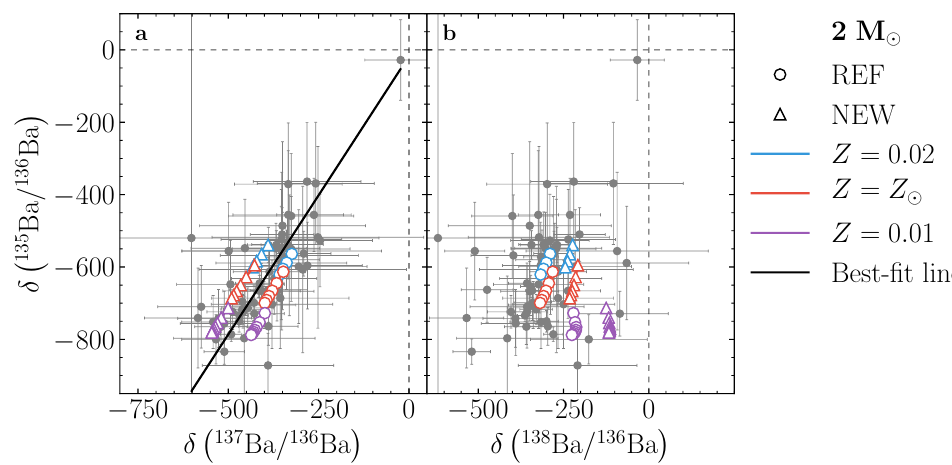
Figure 4. Three-isotope plot of δ 135 Ba/ 136 Ba vs. δ 137 Ba/ 136 Ba ( a ) and δ 135 Ba/ 136 Ba vs. δ 138 Ba/ 136 Ba ( b ). Theoretical stellar predictions calculated under different (n, γ ) data set are compared to MS SiC grain data from [51,60,61]. In panel ( a ), the best-fit line of grain data (black solid) is shown (see text for details). Symbols corresponds to different TPs for the C-rich phase, i.e., when C/O > 1 in the envelope and condensation of SiC is most likely to occur. Plotted are 2 σ